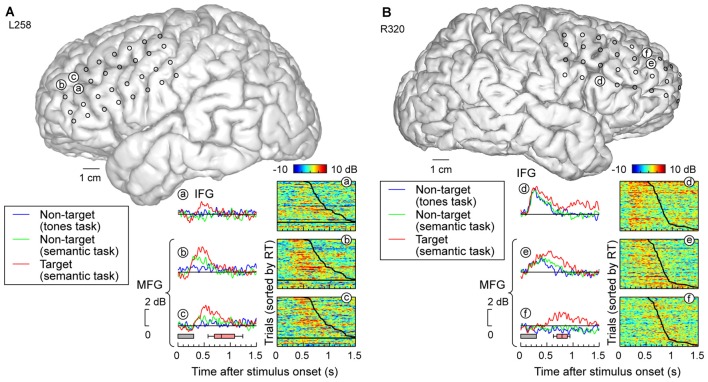
High gamma responses recorded from prefrontal cortex (PFC; inferior and middle frontal gyri; IFG and MFG). (A) Data from left (language-dominant) hemisphere (subject L258). (B) Data from right (language non-dominant) hemisphere (subject R320). See legend of Figures 3A,B for details.